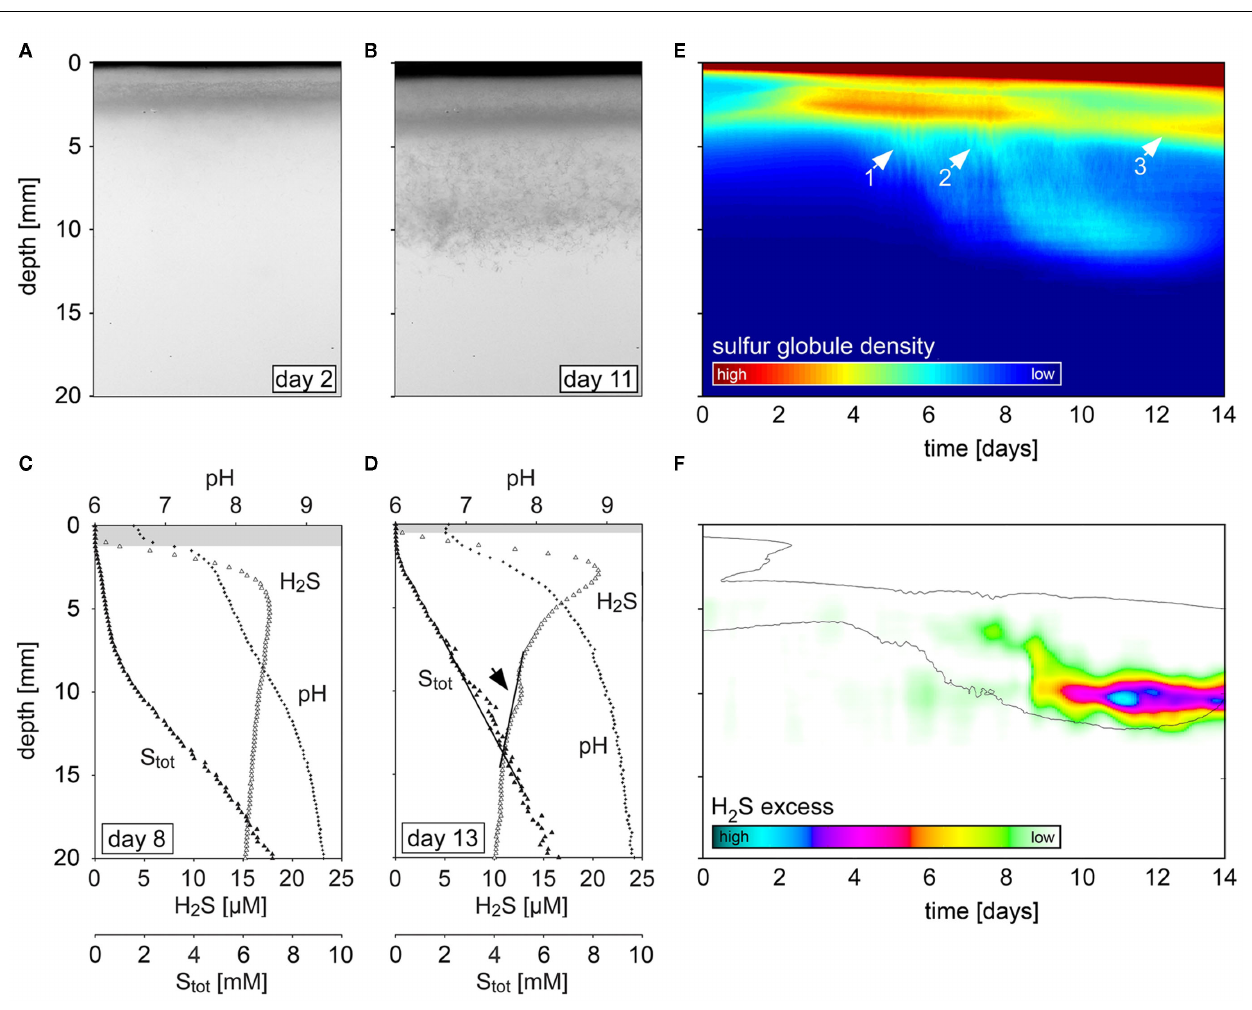
FIGURE 2 | Relationship between the migration of Beggiatoa sp. 35Flor filaments and the dynamics of O 2 , pH, H 2 S, and S tot (total sulfide) in gradient cultures with high sulfide flux. (A+B) Images of culture tubes showing the filament distribution after 2 and 11days. (C+D) Examples of pH, H 2 S, and total sulfide profiles in 8- and 13-day-old gradient cultures. Shaded areas mark the oxic zone. (E) Average sulfur-globule density as a function of time and depth, showing the dynamics of the filament distribution and their sulfur content. Arrows 1 and 2 indicate the onset of major downward migration events, arrow 3 indicates the onset of an increase in the filament density in the mat at the oxygen–sulfide interface. Although the timing of